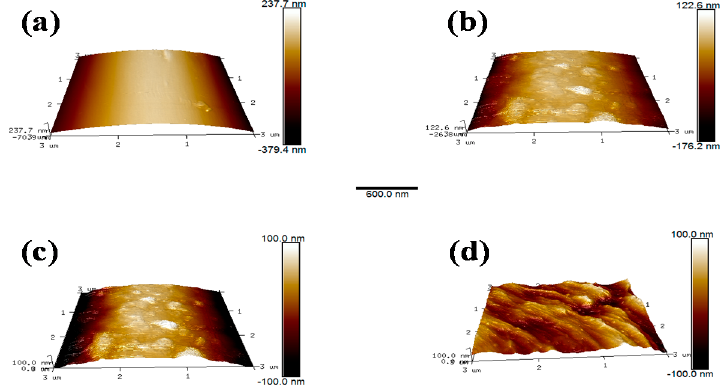
Figure 11. SEM images of aramid fiber before and after modification. (( a ) AF0; ( b ) AF1; ( c ) AF2 without scCO 2 processing; ( d ) AF2; ( e ) AF3 without scCO 2 processing; ( f ) AF3; ( a - T ) : AF0 sample were treated under 150 °C for 1 h).